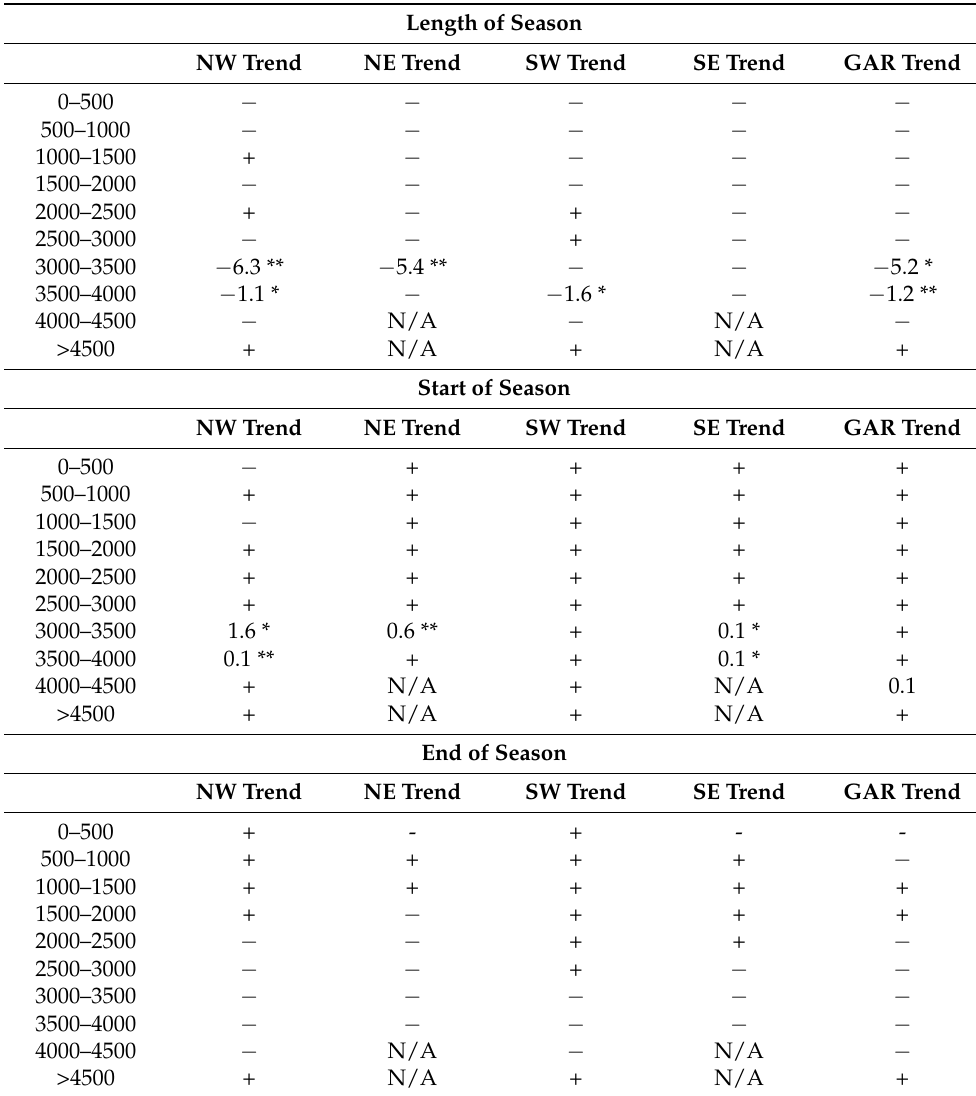
Table 5. Trends in the snow cover metrics by elevation band and subregion in days per decade. * Indicates a trend significant at the 90% confidence level; ** indicates a trend significant at the 95% confidence